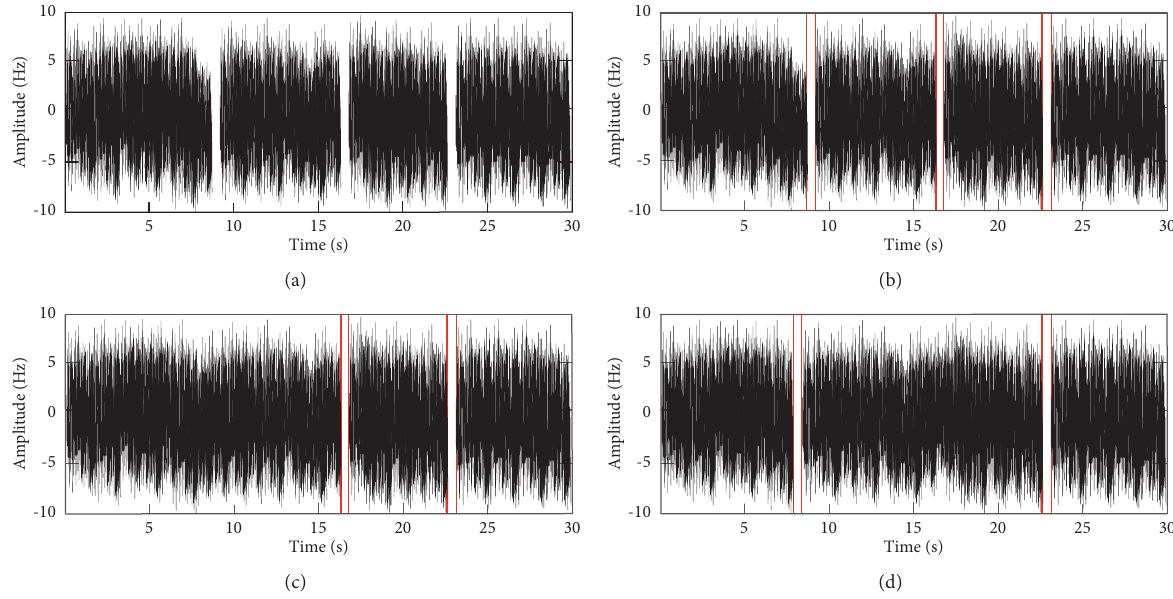
Figure 4: Comparison of segmentation results. (a) Original waveform. (b) The method of this paper. (c) Real-time audio segmentation method based on adaptive threshold adjustment. (d) Audio segmentation algorithm based on hierarchical entropy